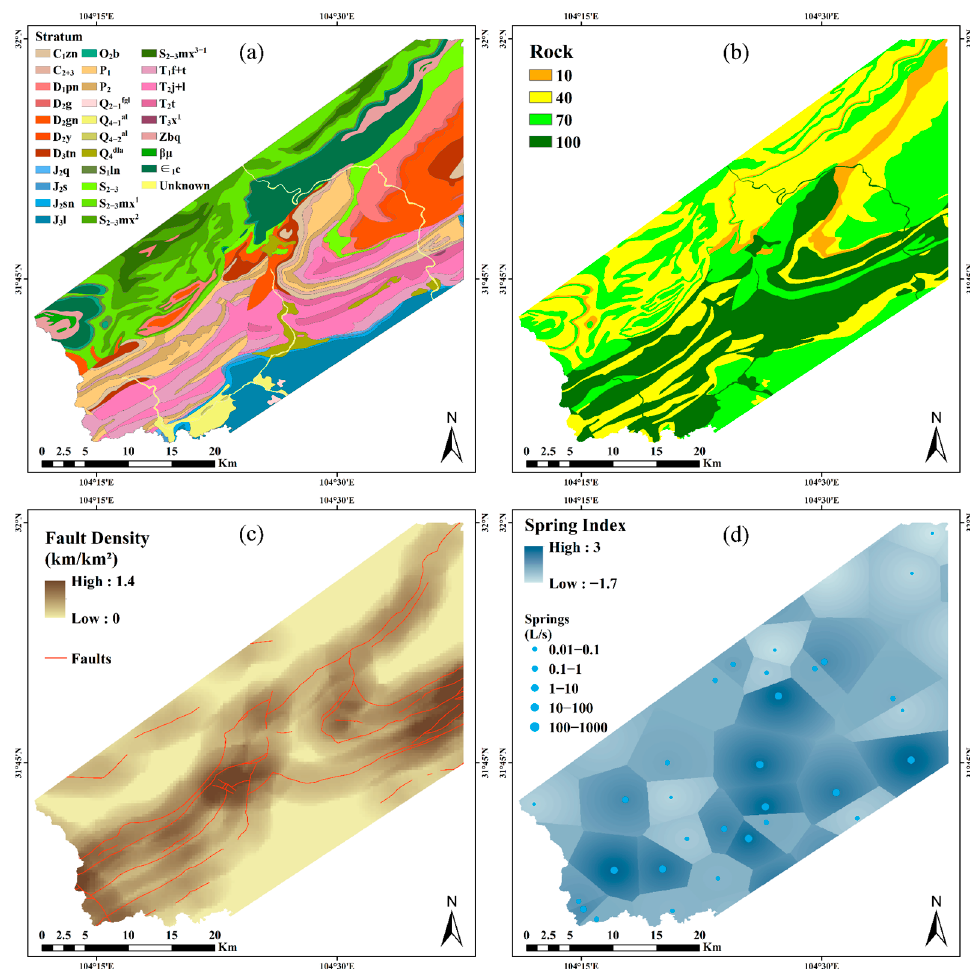
Figure 5. The spatial database constructed for groundwater potential Ⅱ : ( a ) stratum (stratigraphic